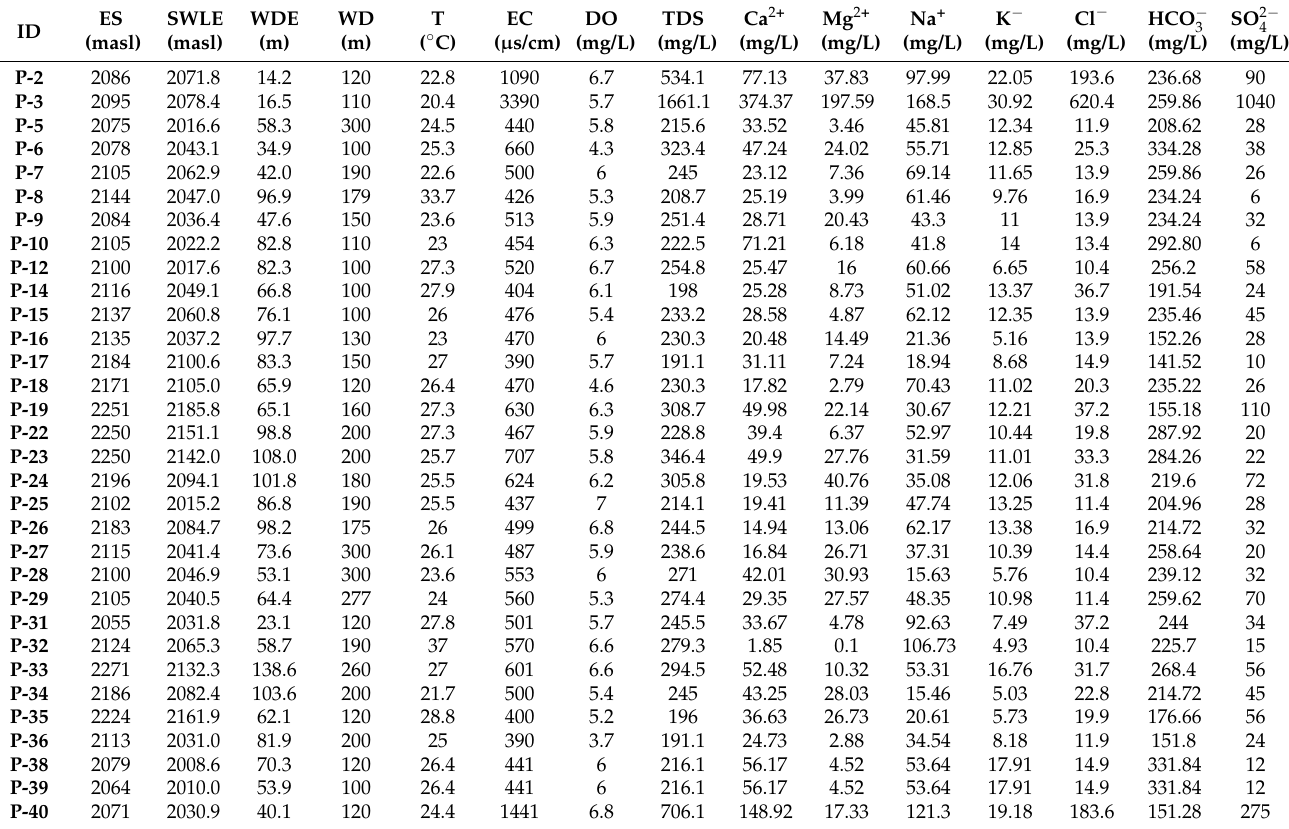
Table 1. Data from the wells sampled in the Calera aquifer for the year 2020 (ES = Elevation at surface, SWLE = Static water level elevation, WDE = Well depth elevation, WD = Well